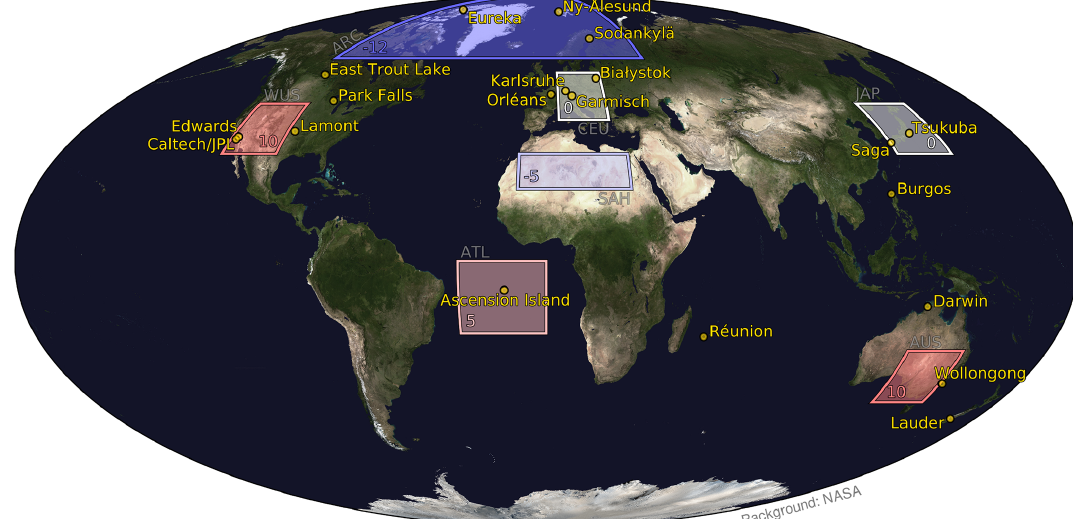
Figure 9. Regions used to train the machine-learning regressor comprising the Arctic (ARC), the western United States (WUS), central Europe (CEU), Japan (JAP), the Sahara (SAH), the South Atlantic (ATL), and Australia (AUS). The corresponding numbers specify the regional corrections applied to the methane climatology before learning in parts per billion, which are also colour-coded in the borders and backgrounds of the regions (blue for negative and red for positive corrections). The yellow circles highlight the TCCON sites used in the